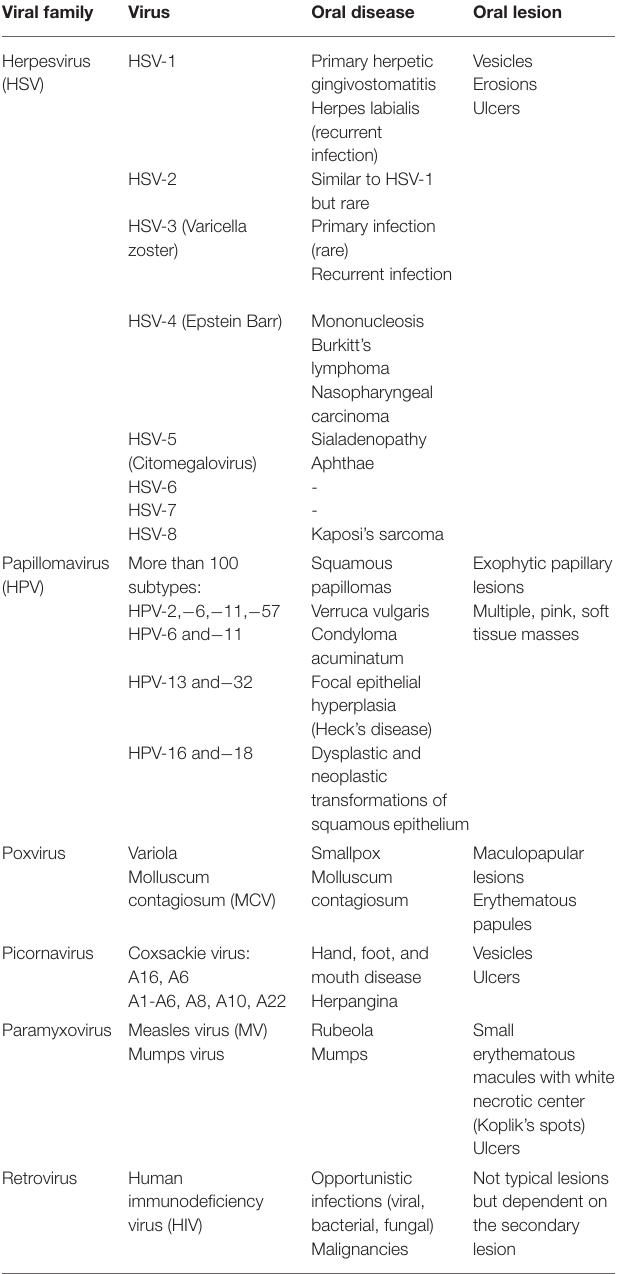
TABLE 1 | Viruses associated with oral lesions. Viral family Virus Oral disease Oral